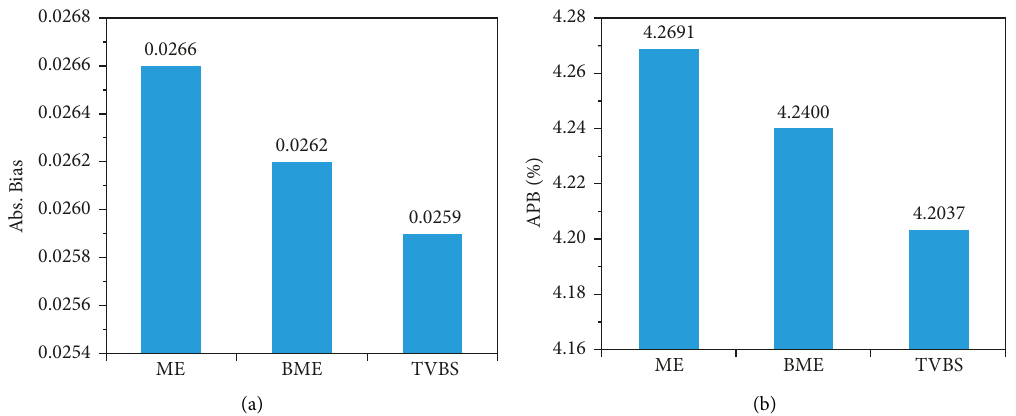
Figure 5: Comparison of three methods for the four-alternative ICLV model: (a) overall mean value of Abs. bias and (b) overall mean value of APB